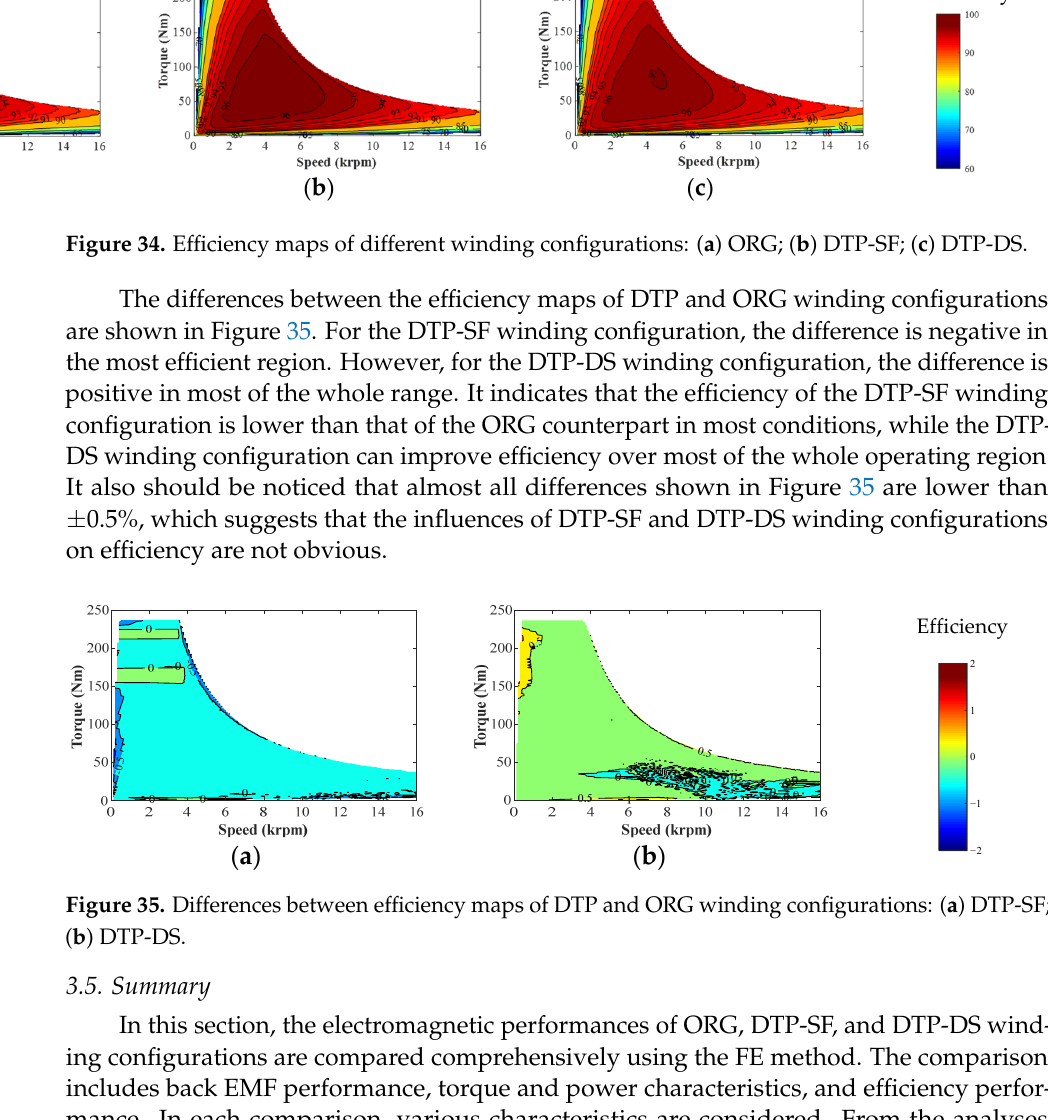
Figure 33. Iron loss maps of different winding configurations: ( a ) ORG; ( b ) DTP-SF; ( c ) DTP-DS.